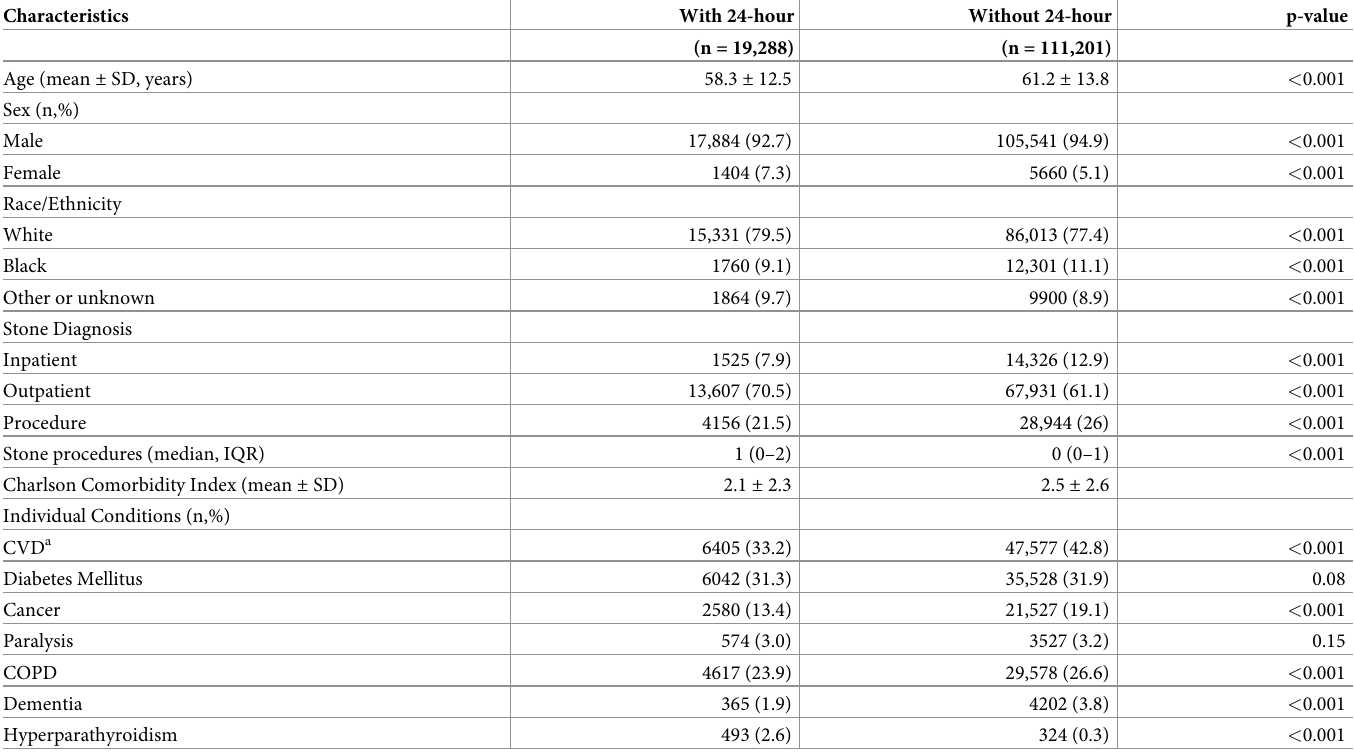
Table 2. Baseline characteristics of stone formers with and without a 24-hour urine collection.